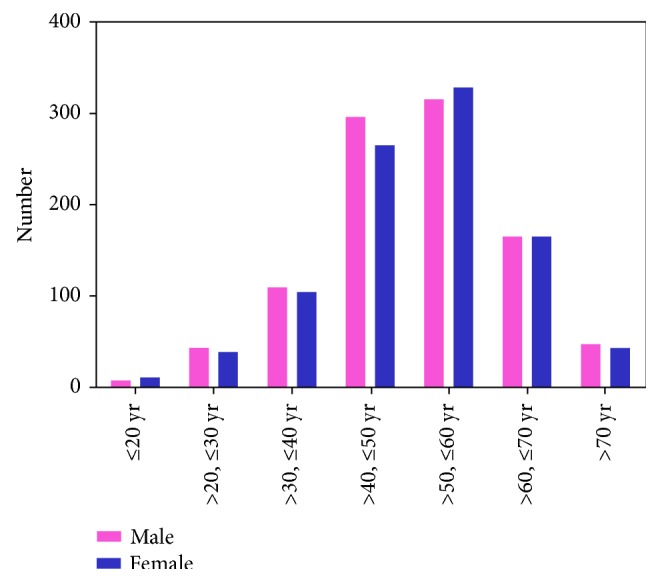
The distribution of patients according to age.